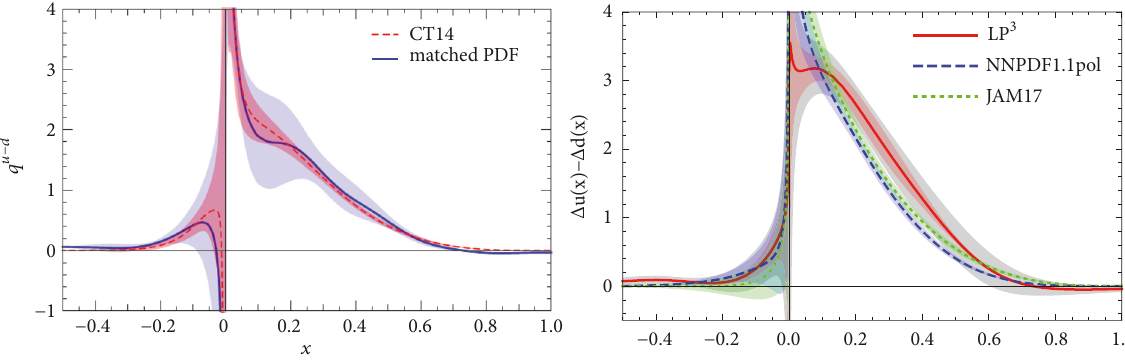
Figure 24: Left: LP 3 ’s final estimate of unpolarized PDF at 3 GeV (blue curve) plotted together with the phenomenological distribution CT14 [210] (dashed red line). Right: LP 3 ’s helicity PDF at 3 GeV (red curve) and global fits data from NNPDFpol1.1 [207] DSSV [217], JAM [215]. Source: [218, 219] (arXiv), reprinted with permission by the